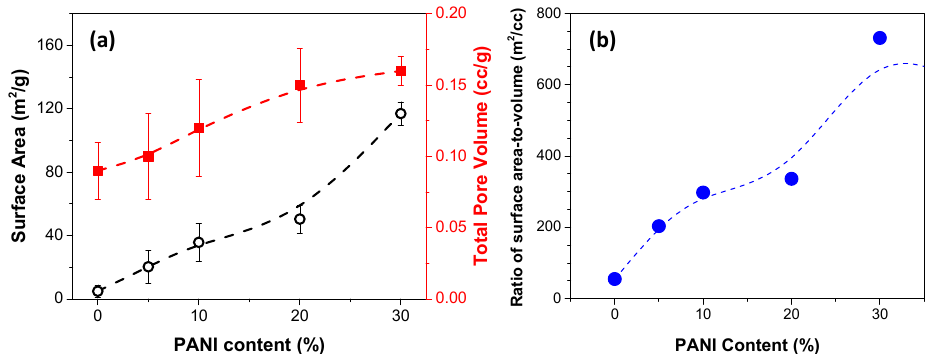
Figure 8. ( a ) BET specific surface area (black hollow circle) and total pore volume (red filled square), ( b ) ratio of surface area to volume (blue filled circle) as a function of PANI content. The connecting spline dotted curves are only to guide the eyes for the observation of the trend.